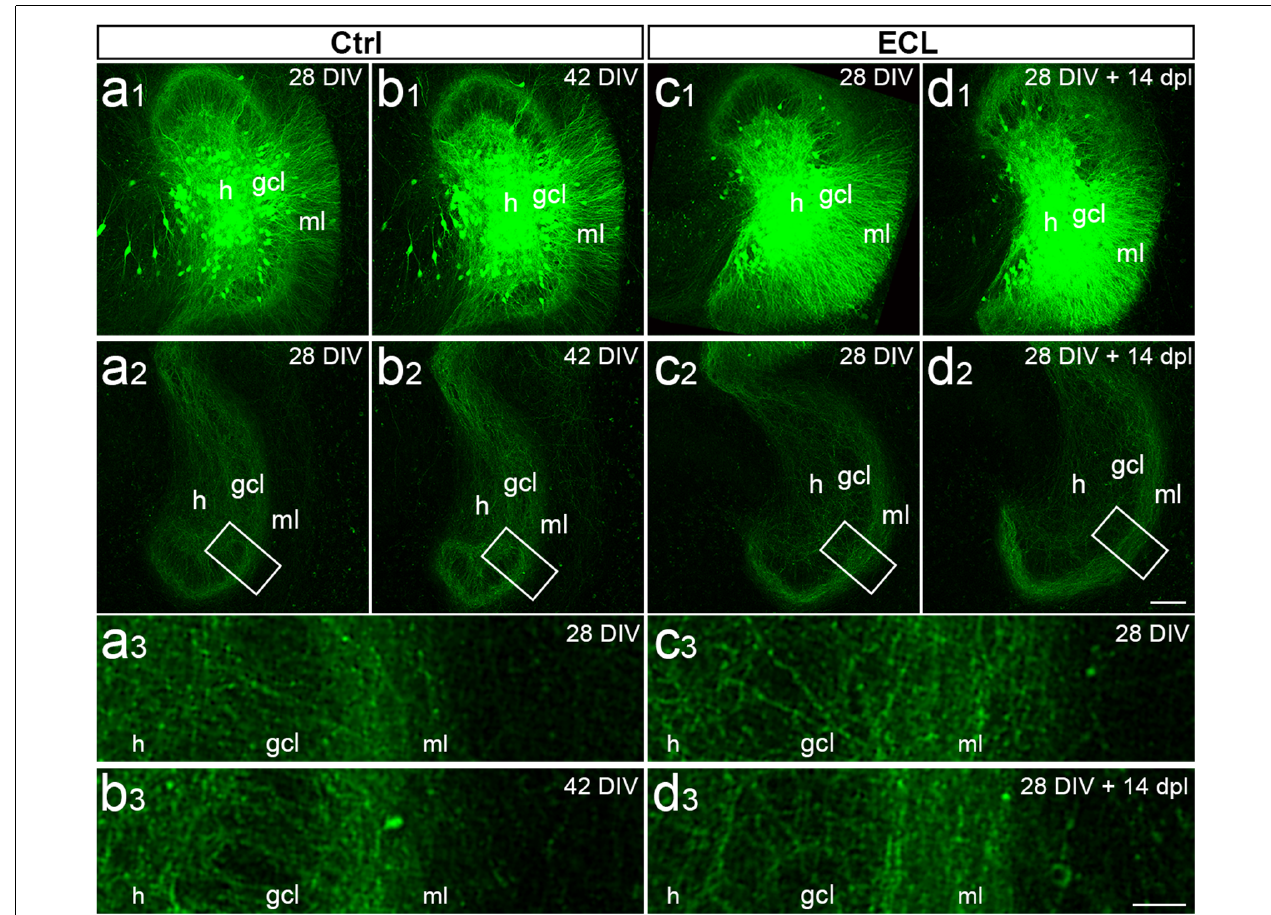
FIGURE 3 | Viral tracing and time-lapse imaging confirm attenuated sprouting response of older cultures. (A–D) Imaging of old (DIV 28) entorhino-hippocampal double cultures without (Ctrl; A,B ) and with entorhinal cortex lesion (ECL; C,D ). At DIV 4 both sets of cultures received an injection of AAV2-hSyn1-GFP into one hilus (h). On 28 days in vitro (DIV) a subset of cultures served as non-lesioned time-matched controls (A,B) , whereas a second subset of cultures received an ECL (C,D) . (A1,B1) Images of the same virus injected control culture at DIV 28 (A1) and DIV 42 (B1) . Commissural axons in the contralateral dentate gyrus are illustrated at DIV 28 (A2) and DIV 42 (B2) respectively. The boxed areas are shown at higher magnification (A3,B3) , illustrating minimal changes occurring during the 14 days observation period. (C1,D1) Images of the same virus injected culture at DIV 28 (C1) and 14 days post-lesion (dpl) (D1) . Commissural axons in the contralateral dentate gyrus are shown at DIV 28 (C2) and DIV 28 + 14 dpl (D2) . The boxed areas are shown at higher magnification (C3,D3) illustrating no major differences between DIV 28, DIV 42, and 14 dpl. gcl, granule cell layer. Scale bar: 100 µ m ( A1–D1 and A2–D2 ); 25 µ m (A3–D3)